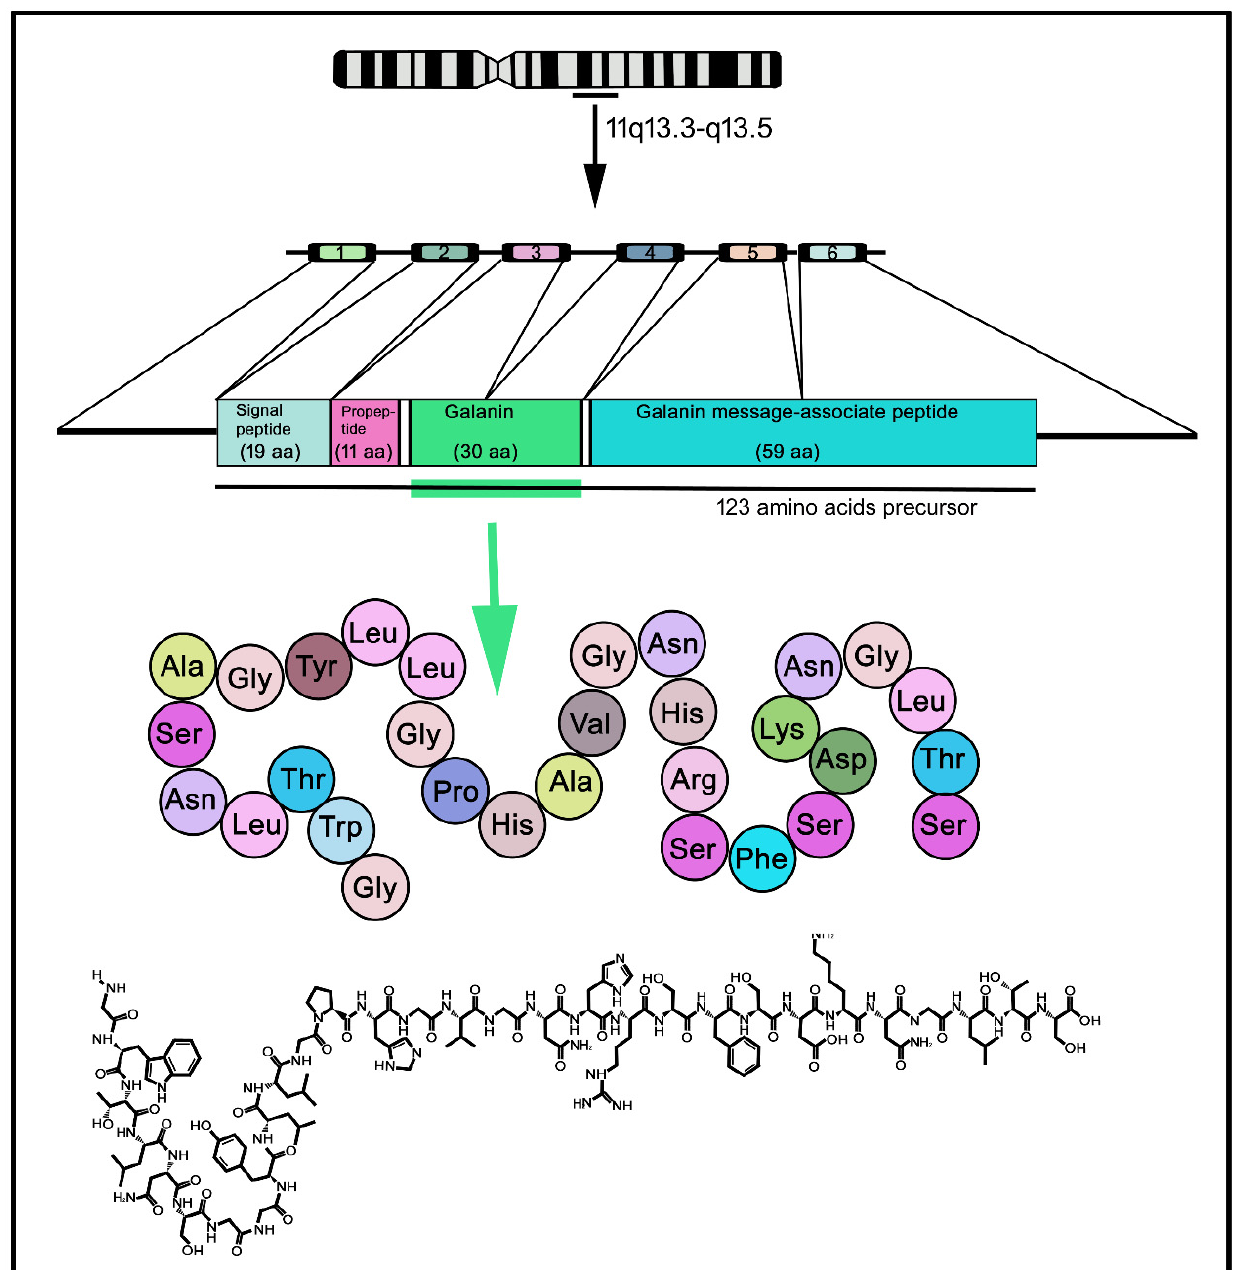
Figure 2. Transcription–maturation–translation processing of GAL, from human chromosome 11.